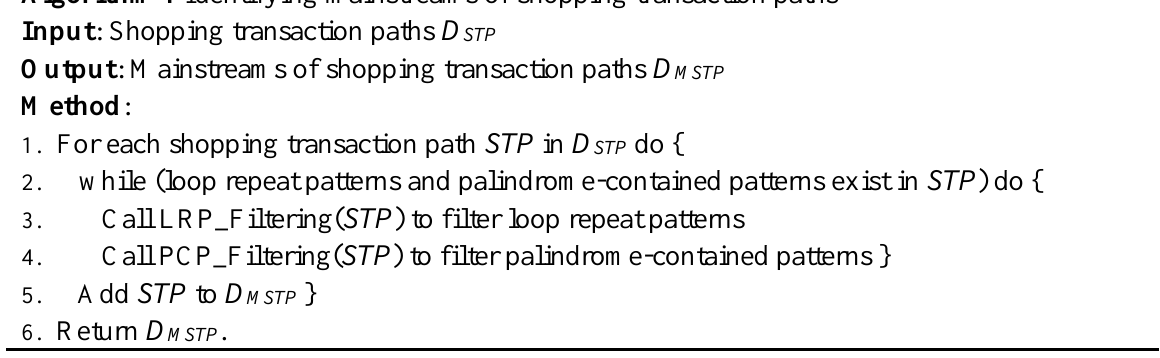
Algorithm 1 Identifying mainstreams of shopping transaction